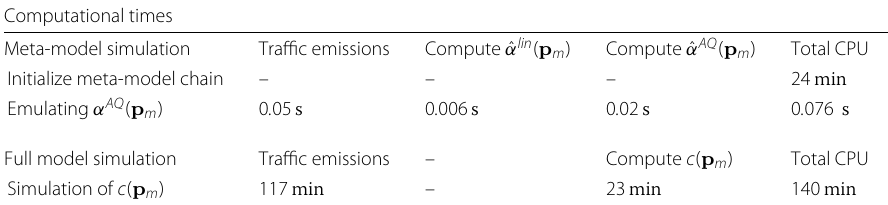
Table6 Computation times using the meta-model or full model chain Computational